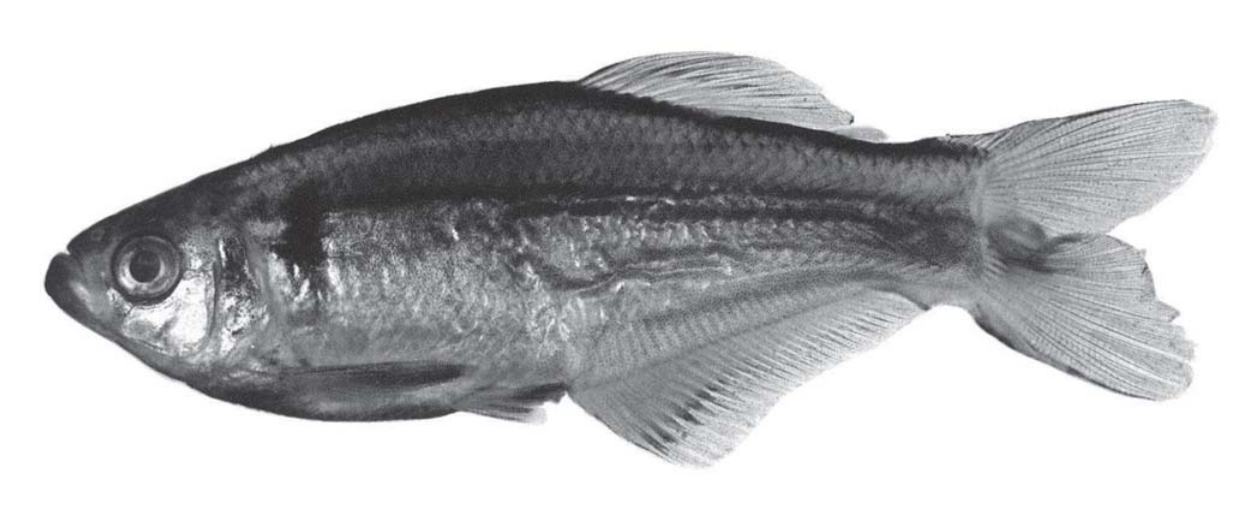
Fig. 70. Mimagoniates rheocharis , adult male, MZUSP 40278, holotype, 47.3 mm SL, Brazil, Santa Catarina State, rio Faxinalzinho at Mãe dos Homens, near Praia Grande. Modified from Menezes & Weitzman